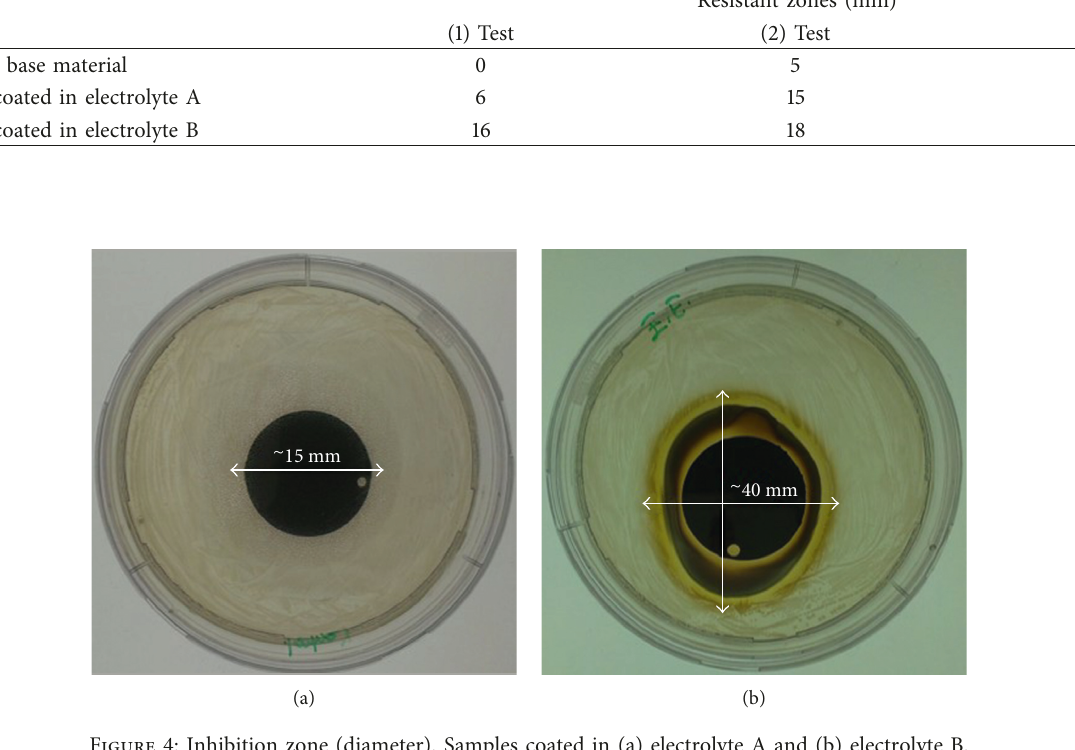
Table 2: The tests statistics are conducted 3 times with 3 repetitions each time under the same conditions. Samples